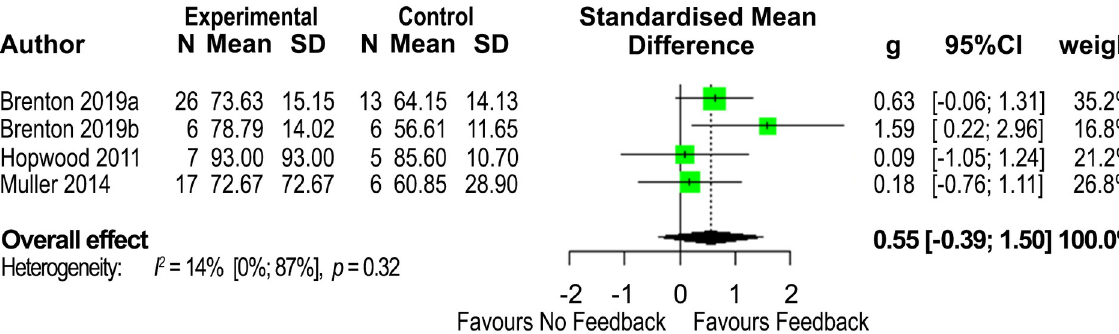
Fig 3. Forrest plot displaying the Hedge’s g effect sizes and 95% confidence intervals (CIs) for the action outcome measure of performance success, among cricketers for feedback-involved intervention groups compared to no-feedback control groups.